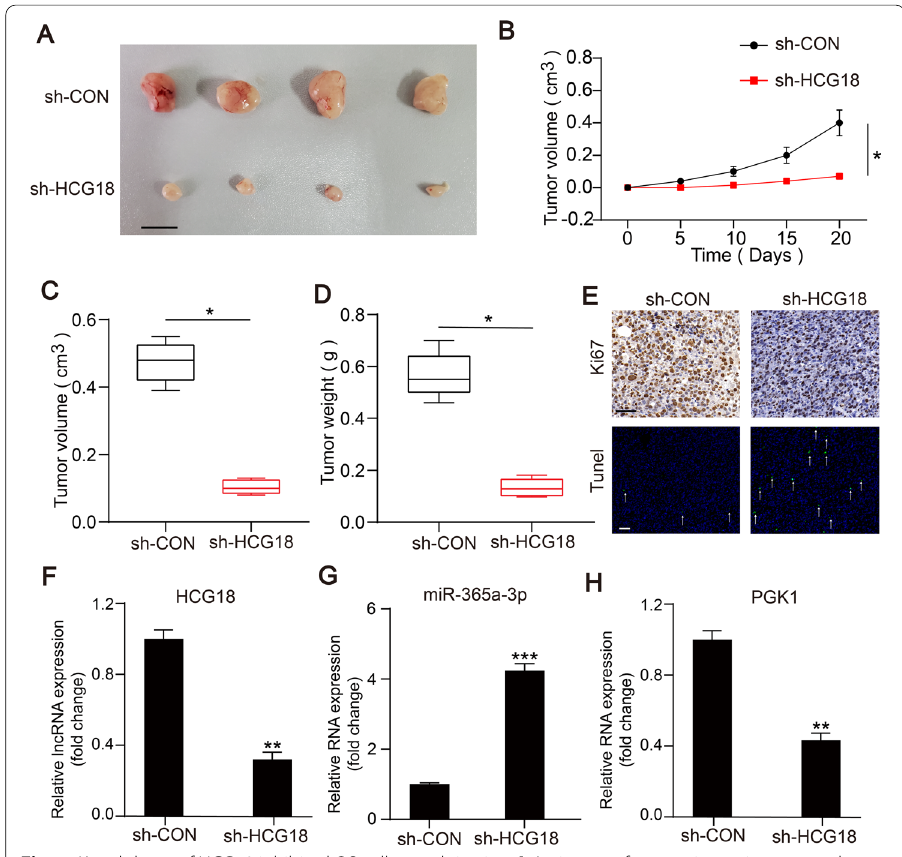
Fig. 7 Knockdown of HCG18 inhibited OS cell growth in vivo. A An image of tumor tissues is presented. Scale bars 1 cm. B‑D Tumor growth curve, tumor volume and weight in sh-HCG18 group and sh-NC group = were measured. E Expression of Ki67 and the rate of apoptosis in the xenograft tumors from the sh-HCG18 and sh-Control mice were monitored. A TUNEL positive cell is indicated (arrow). F–H Expression of HCG18, miR-365a-3p and PGK1 was monitored in xenograft tumors from sh-HCG18 group and sh-NC group. * represents P < 0.05, ** represents P < 0.01, *** represents P < 0.001. All experiments were repeated three